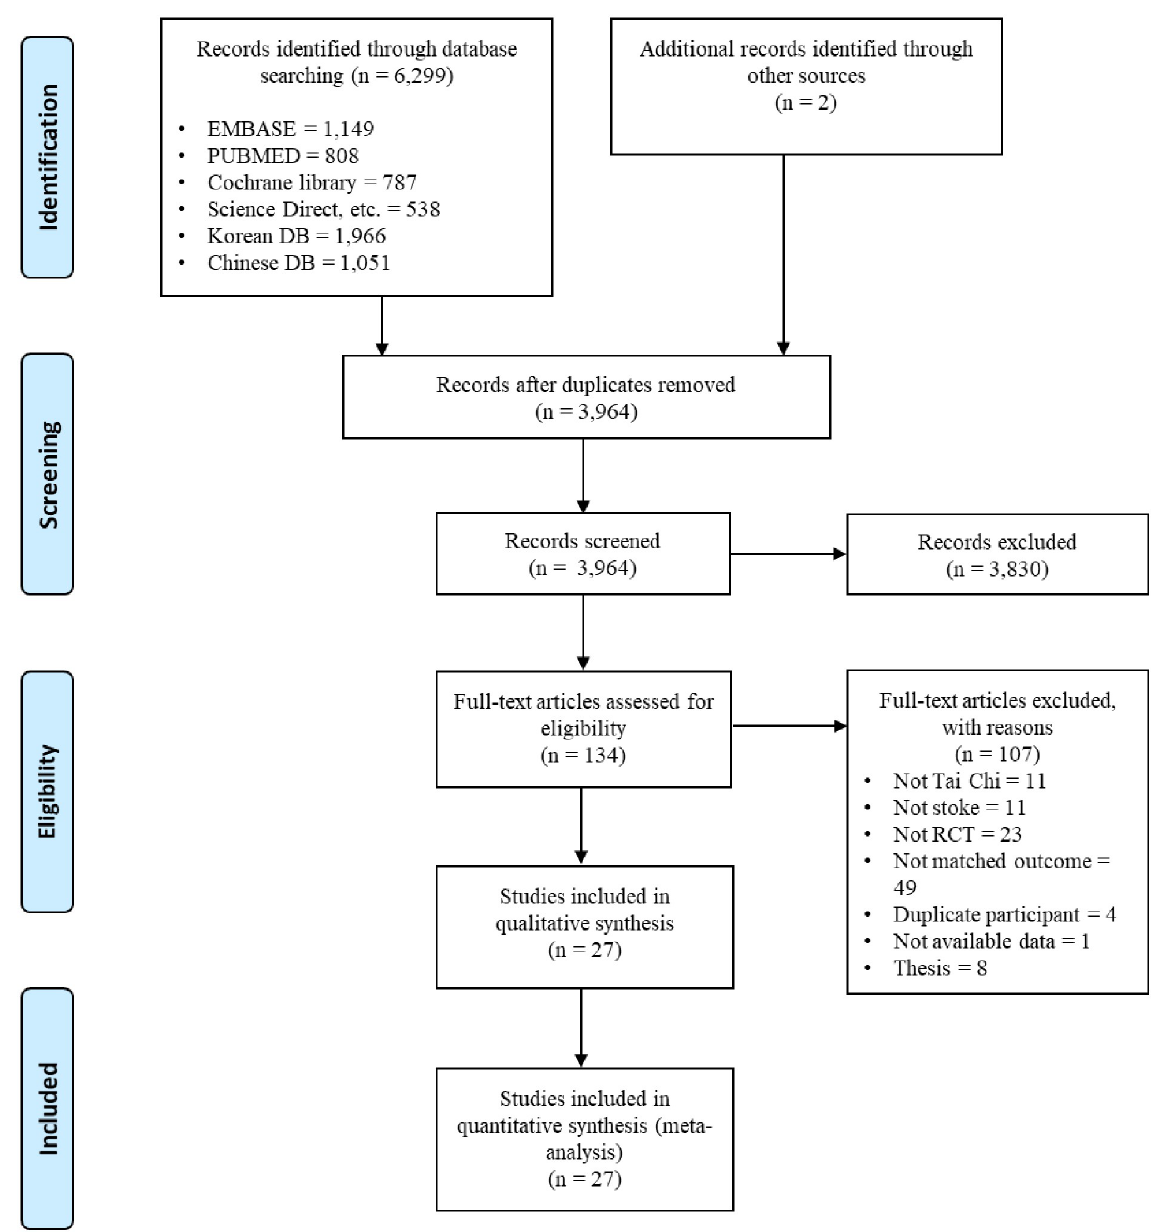
Fig 1. Flow diagram of the study selection